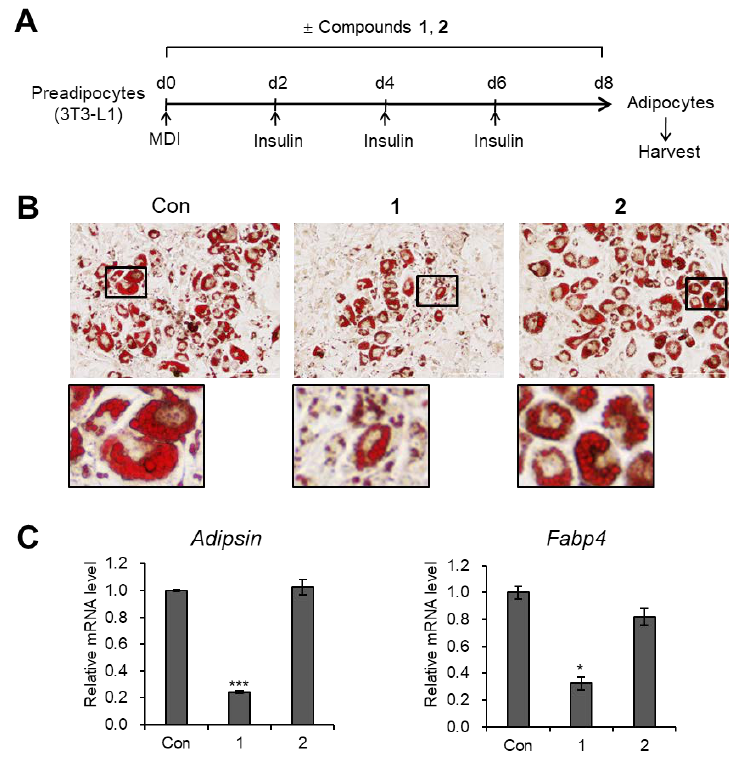
Figure 5. Inhibitory e ff ects of compounds 1 and 2 on adipogenesis. ( A ) Schematic representation of the di ff erentiation 3T3-L1 cells into adipocytes. Compounds 1 and 2 were used to treat the cells during the entire process of di ff erentiation. ( B ) Oil Red O staining of 3T3-L1 adipocytes treated with compounds 1 and 2 (20 µ M) during adipogenesis. ( C ) mRNA levels of the Adipsin and Fabp4 in 3T3-L1 adipocytes treated with compounds 1 and 2 (20 µ M) during adipogenesis. Data represent the means ± SEM for n = 3. * p < 0.05, *** p < 0.001.